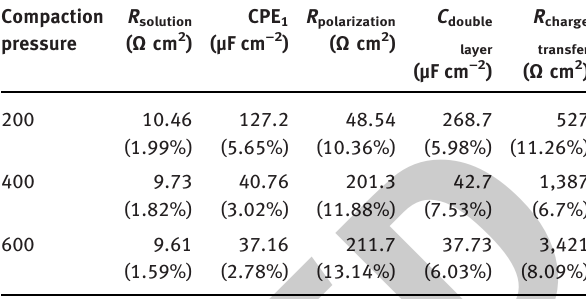
Table 5: Electrochemical impedance spectroscopy parameters obtained for 316L samples sintered at